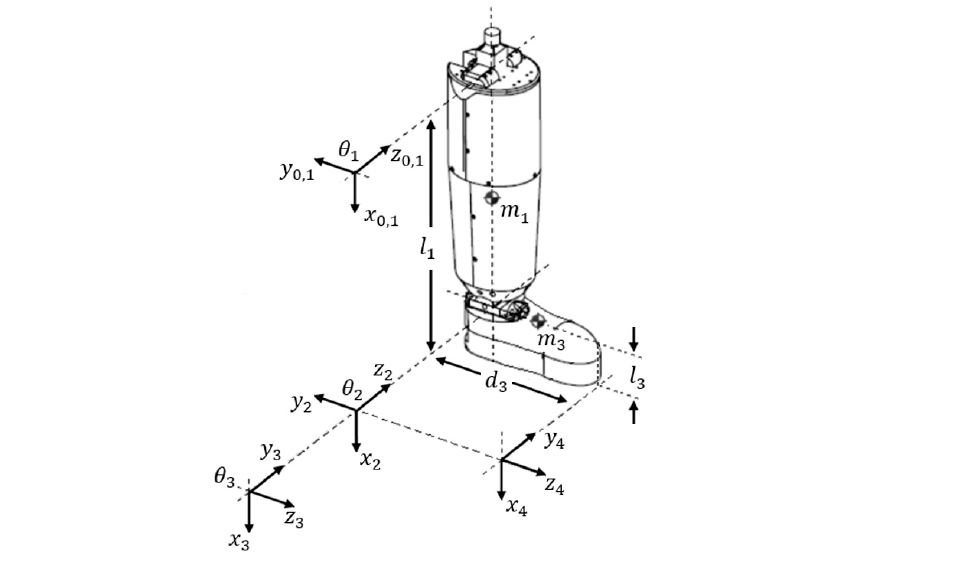
Figure 1. The new robotic-type three-axes above-knee prosthesis. The transformation matrices of the new above-knee prosthesis are obtained as